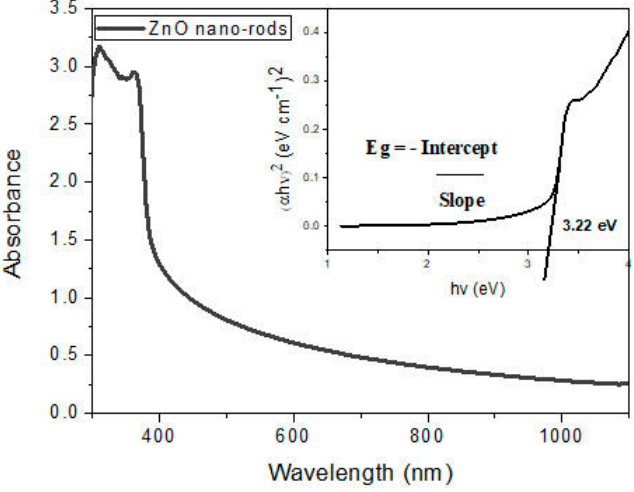
Figure 15. The absorption spectrum of ZnO nanorods and Tauc plot extracted from the absorption spectrum.